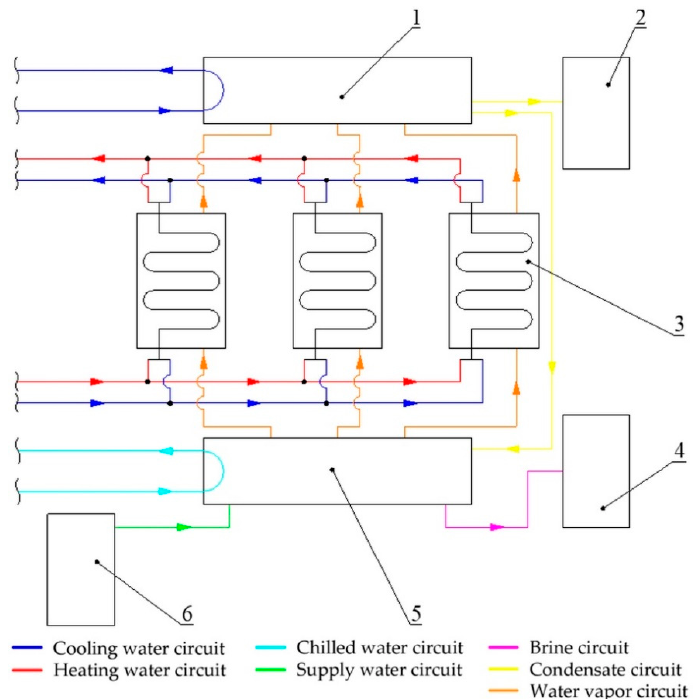
Figure 1. The simplified diagram of the investigated adsorption chiller with desalination function.